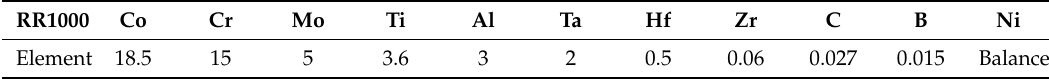
Table 1. RR1000 nominal composition (wt. %).